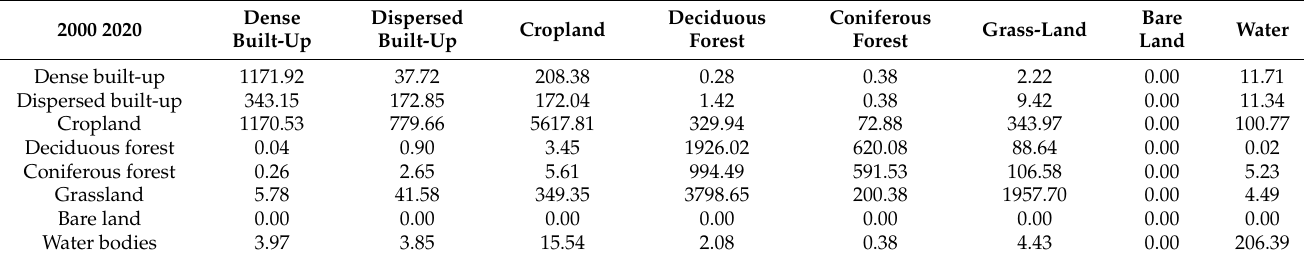
Table A5. Land cover area transfer matrix for Beijing from 2000 to 2020 (km 2 ).